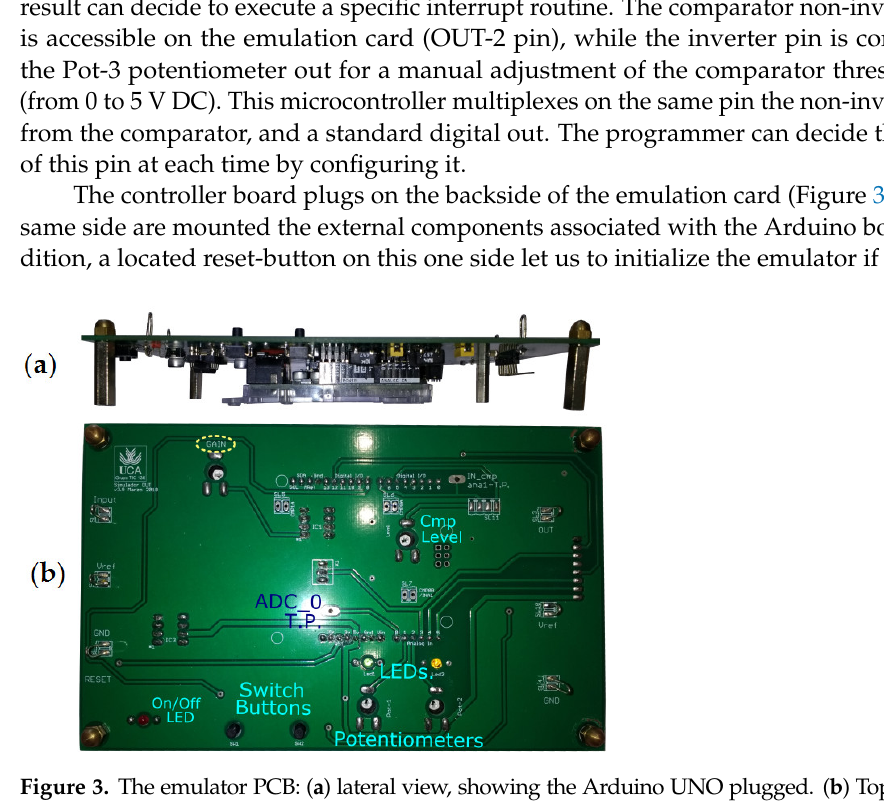
Figure 4. Emulator PCB, bottom side (with a DUE board plugged). Beginning an emulation procedure requires choosing a symbolic figure of the simu- lated circuit. The laboratory instructor has the help of a graphical template where the ele- ments appear in their real physical positions (Figure 5). Over this starting template, we